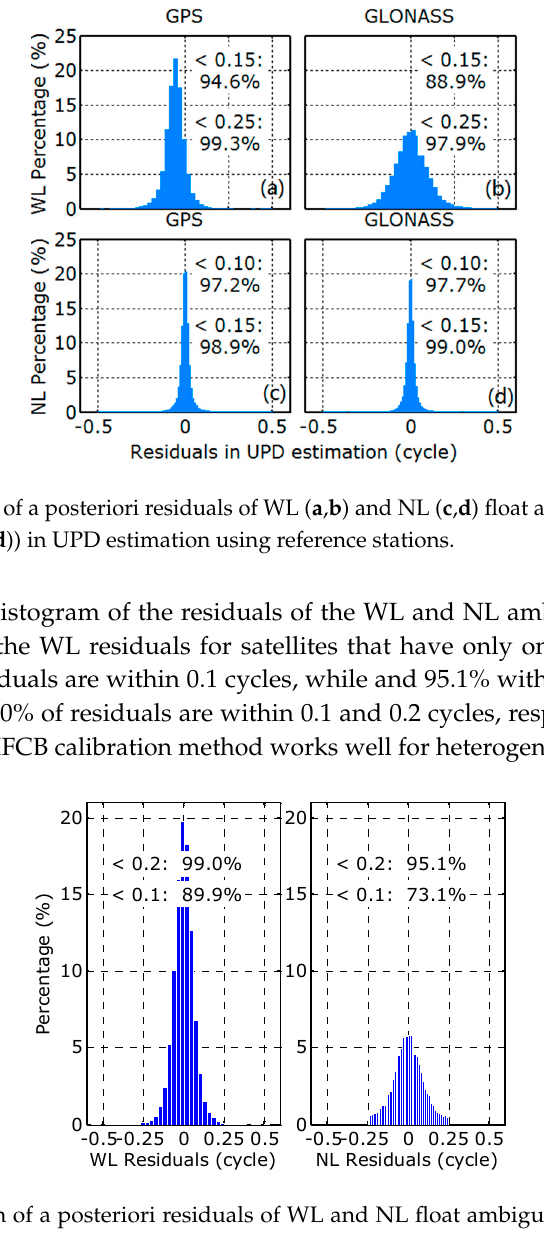
Figure 10. Fixing percentage for kinematic PPP with different strategies for an observation duration of 15 min on each day. Receivers with homogeneous type are used as rover sites.